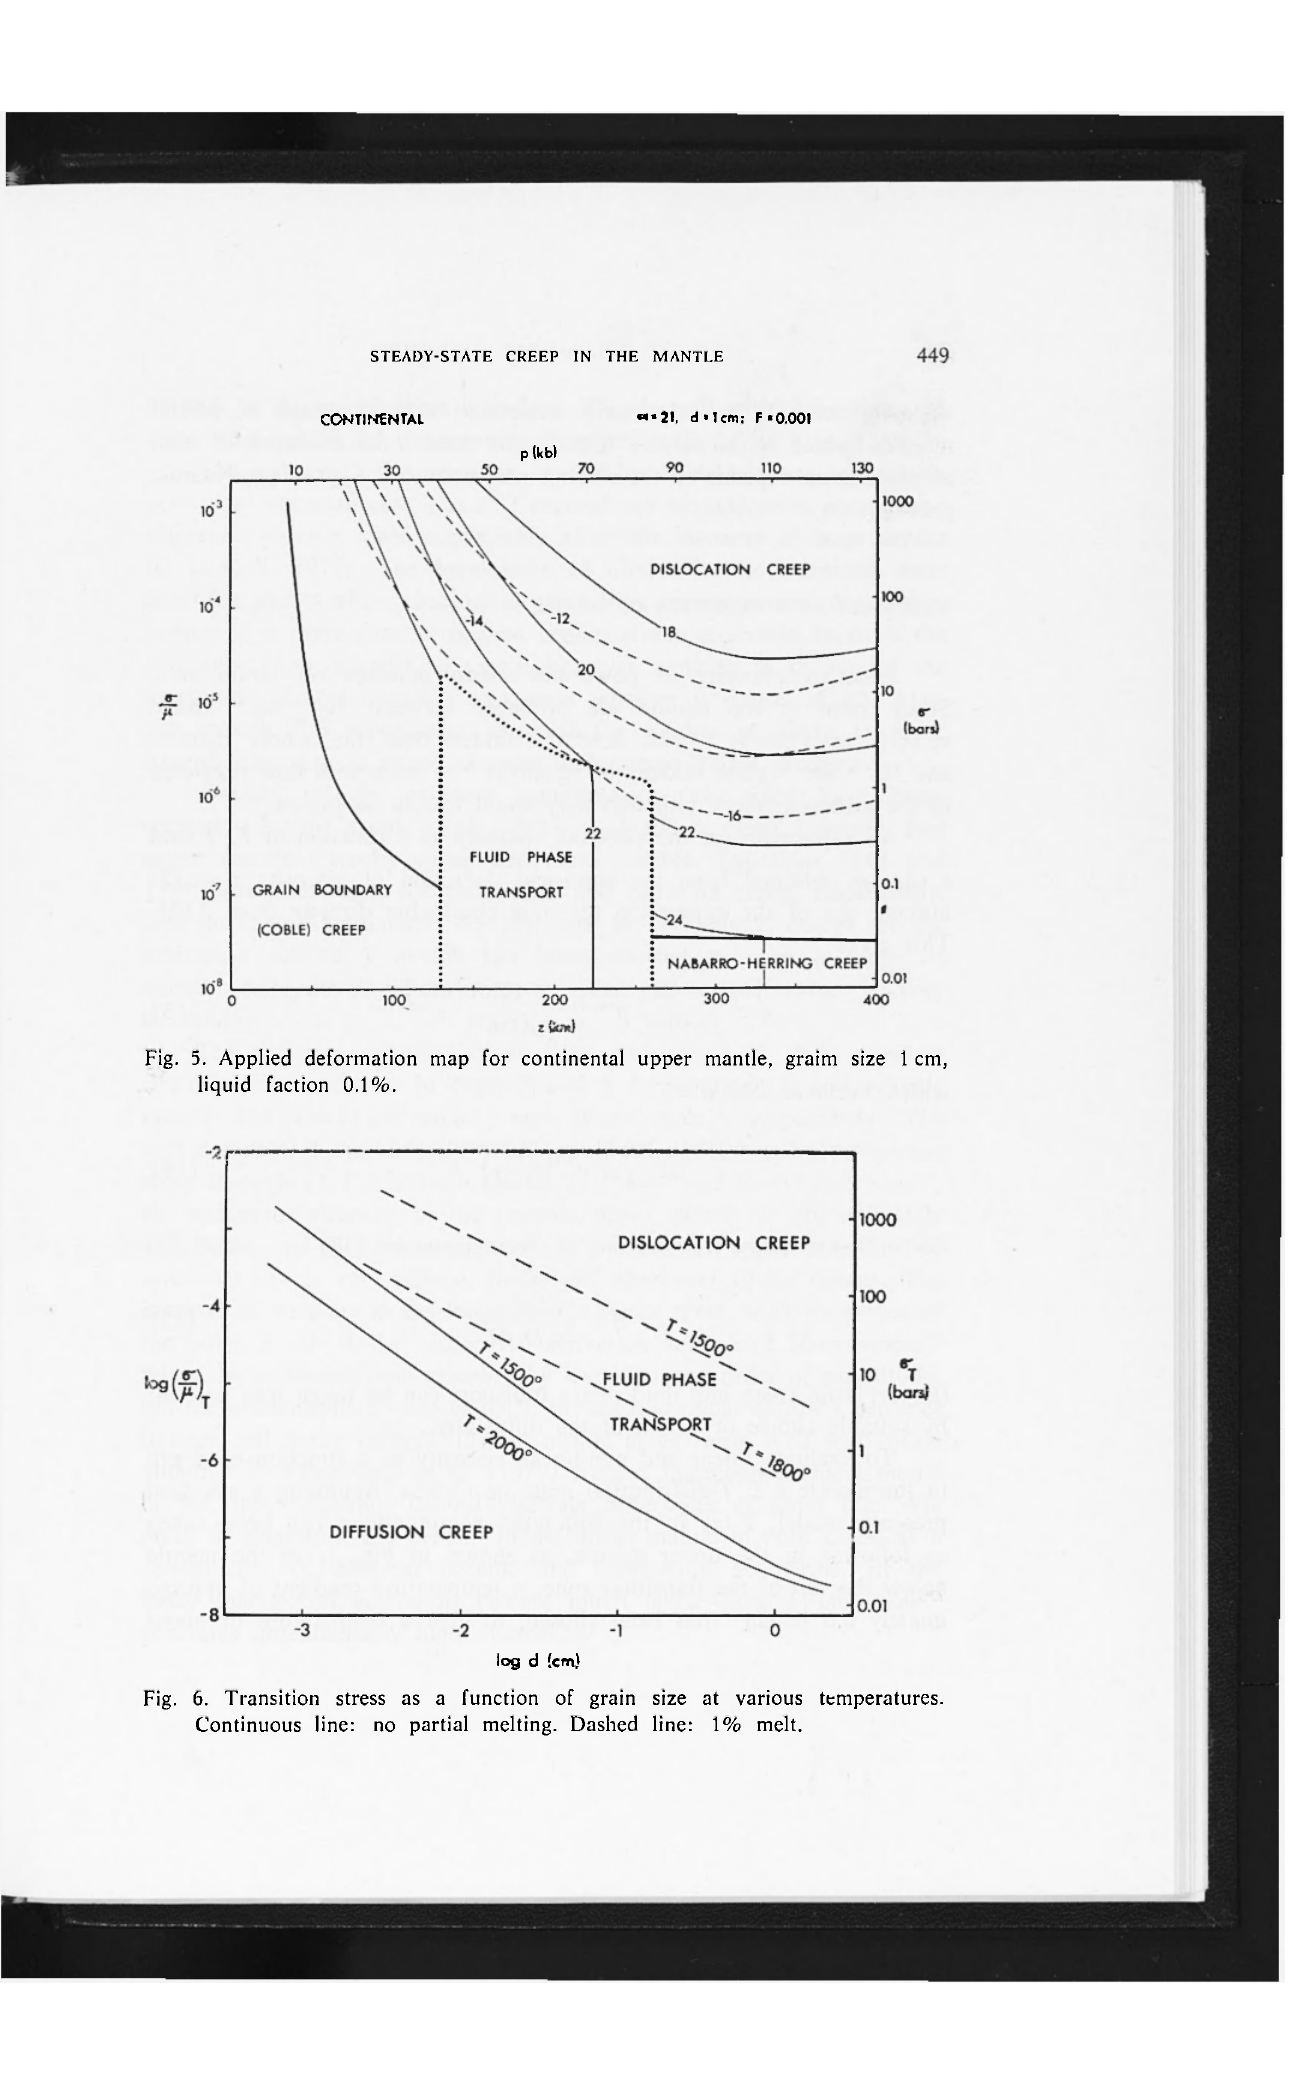
Fig. 5. Applied deformation map for continental upper mantle, graim size 1 cm, liquid faction 0.1%.